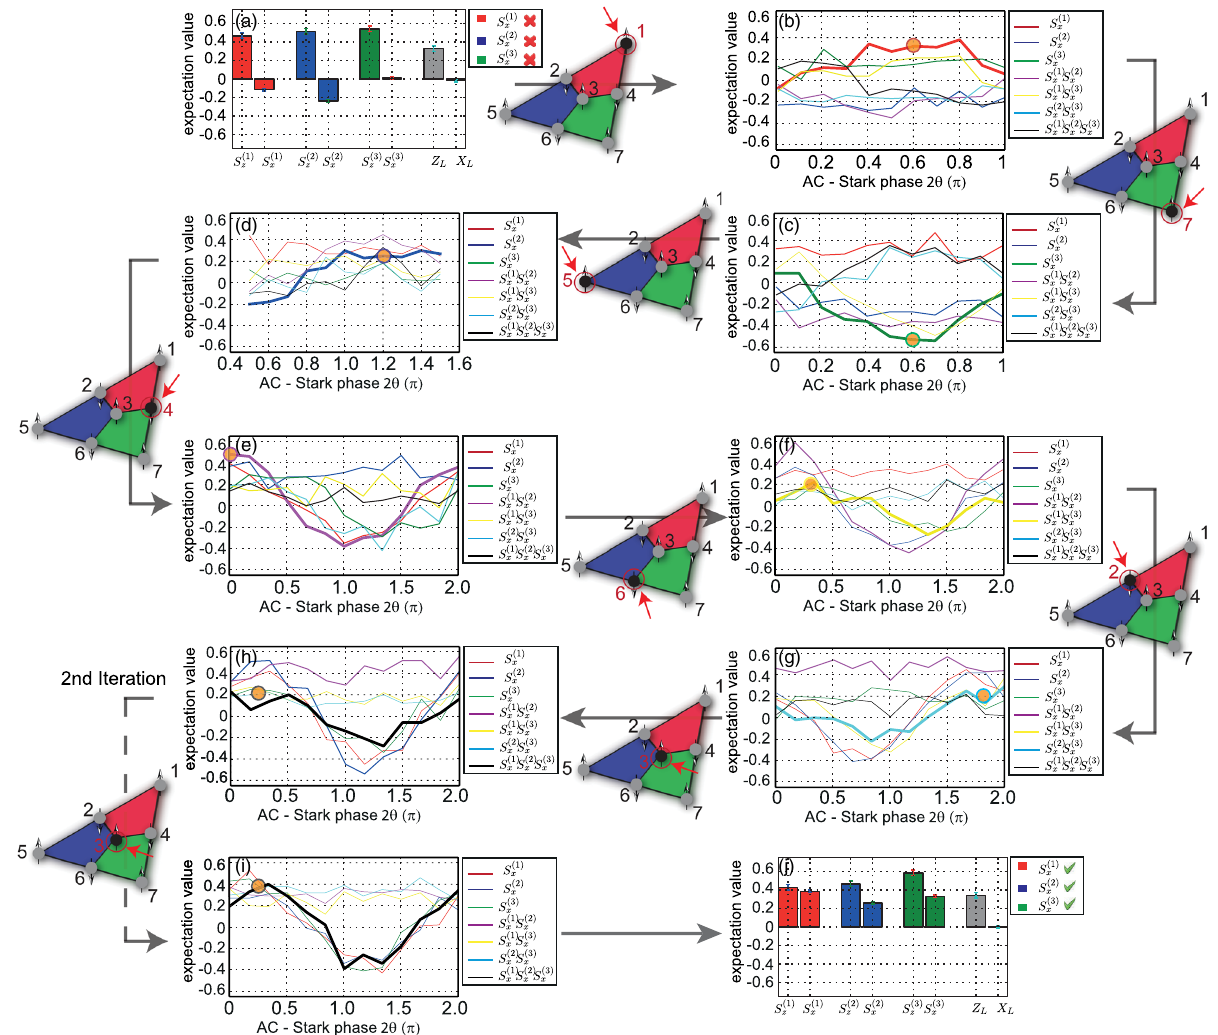
FIG. 3. Experimental phase optimization of the complete seven-qubit quantum error correcting code. Here, the algorithm was applied to the final state resulting from the complete encoding sequence shown in Fig. 1, i.e., three entangling operations applied to the qubits belonging to the first (red), second (blue), and third (green) plaquette of the code. Initially, X -type stabilizer expectation values are nonmaximal (a), indicating the presence of unknown, relative phases in the desired target state. After two rounds of iteratively maximizing the seven expectation values of plaquette operators h S ð the algorithm converges to a set of compensation phases, θ ¼ ½ θ 1 ; … ; θ 7 (cid:2) , for which all X -type stabilizers assume maximal values. The individual phase value θ i to the Z rotation, which is adjusted to maximize the corresponding stabilizer expectation value under consideration (bold line), is indicated by the orange circle for each optimization step [see (b) – (i)]. Note that because of the periodicity in θ i , it is also possible to search for the minimum expectation value of the stabilizer under consideration and add the rotation angle see (c) for an example. The Z - and X -type stabilizers of the logical state j 0 i L after two rounds of optimization steps are shown in (j). Intermediate steps of the second round of optimization are not shown. The experimental parameters are as specified in Fig. # Phases ¼ 2 # plaquettes − 1 : ð 16 Þ